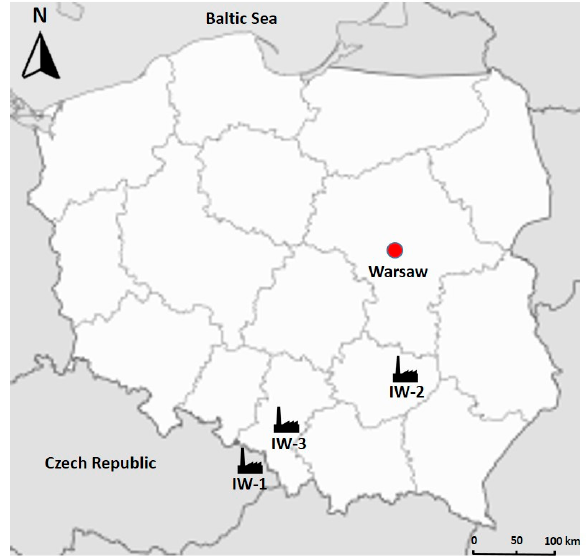
Figure 1. The location of the sampling sites—IW-1 T ř inec ironworks (Czech Republic), IW-2 Ostrowiec (Ostrowiec Ś wi ę tokrzyski ironworks, Poland), and IW-3 Katowice (D ą browa Górnicza ironworks, Poland), and sampling of particulate matter and street dust from Warsaw (Poland).